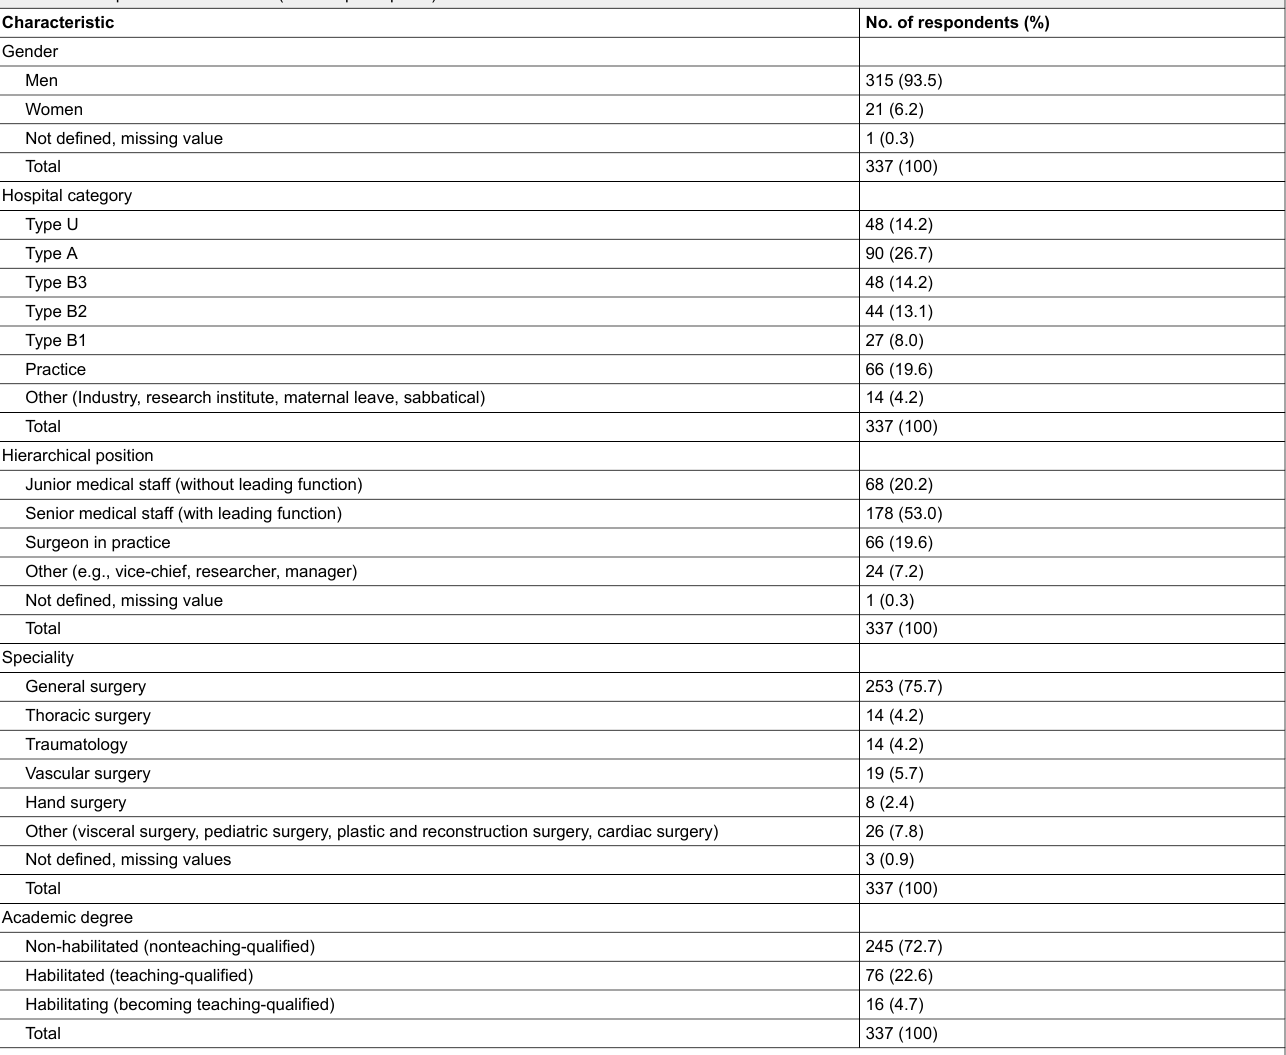
Table 1: Participants’ characteristics (n = 337